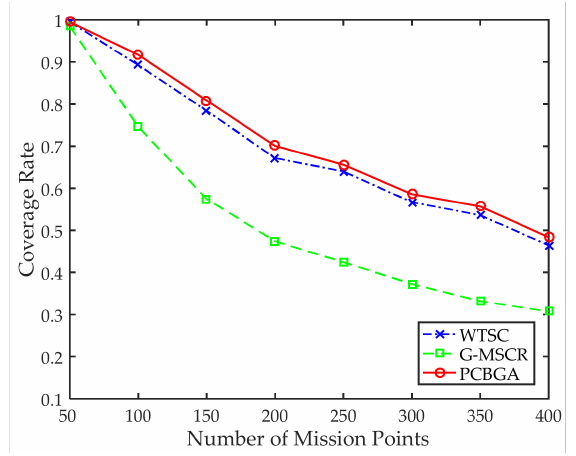
Figure 5. Comparison of the coverage rate with the increase of the mission